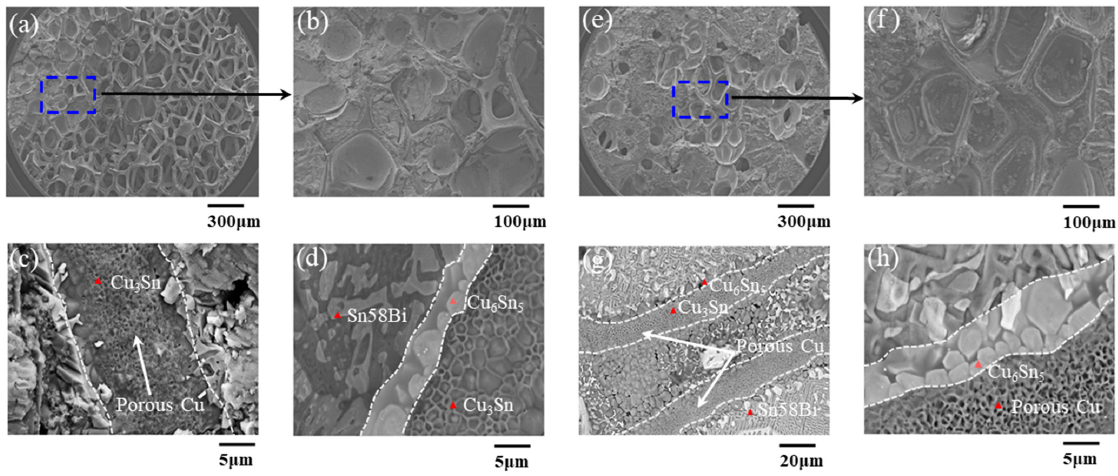
Figure 5. SEM images of joints bonded for different times: ( a – d ) 5 min and ( e – h ) 20